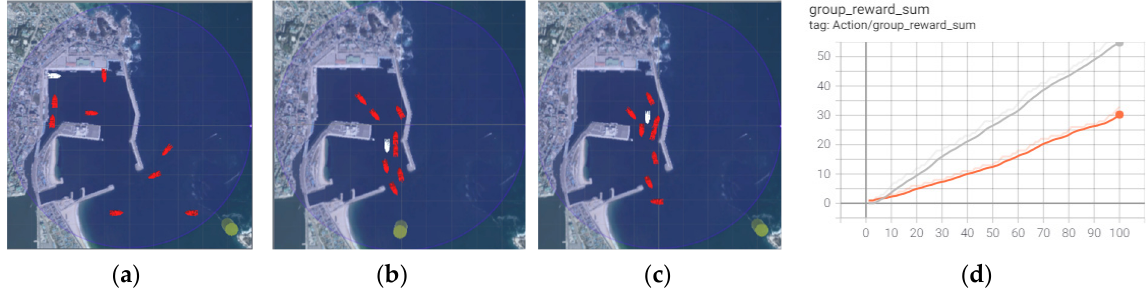
Figure 14. ( a ) Experiment using eight neighboring ships in the initial state waiting for entry into or departure from the harbor. ( b ) Autonomous ship sailing right owing to ILFAS learning; however, the arrival rate to a destination decreased because of poor speed control. The autonomous ship departed to comply with the human-defined navigation rules. ( c ) Random RL waits for all of the outward ships or go ahead of inward or outward ships. The autonomous ship of the random RL rapidly departs after waiting in the harbor because collision is estimated when the harbor gets busy. ( d ) The successful arrival rate to a destination in 100 episodes reduces to 53% for the ILFAS and 30% for the Random RL.